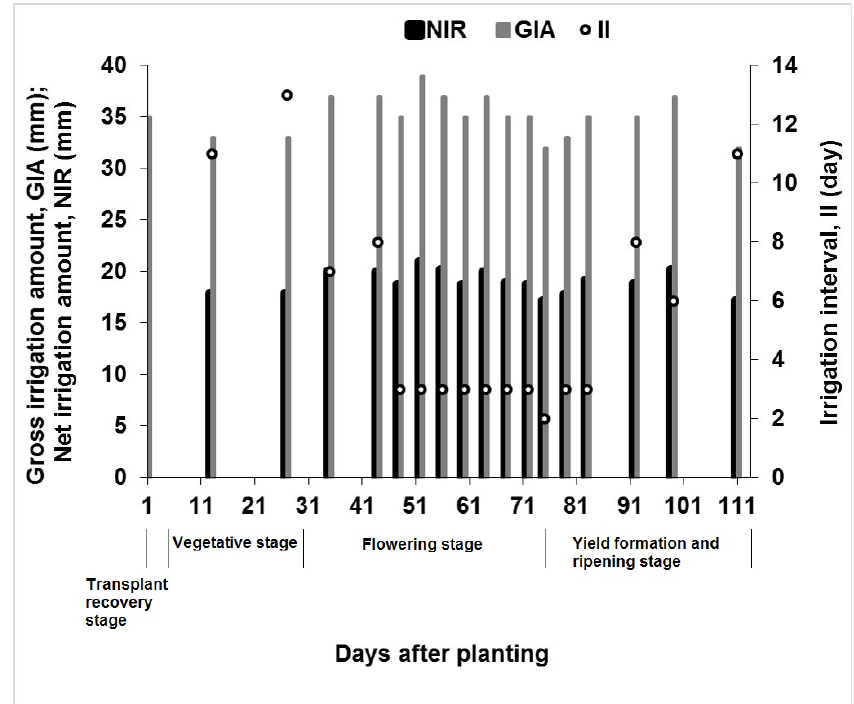
Figure 11. Improved irrigation schedule for tomato cultivation, based on the example of BF1 in the Bongo irrigation scheme. Gross irrigation amount was estimated using a field application efficiency of 55% [19].